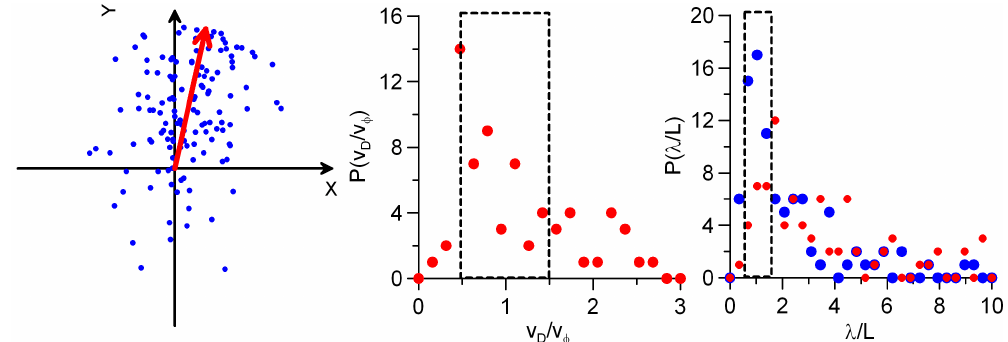
Fig. 6. Statistics of 160 fast crossings. Left: directions of normal vector projections to the XY plane for each CS crossing. Centre: the histogram of values v D (cid:14) v φ . Right: the histogram of values λ (cid:14) L for two frequencies. The blue color denotes the higher frequency and the red color – the smaller one (see text for details). Dashed boxes denote regions roughly corresponding to the theory.